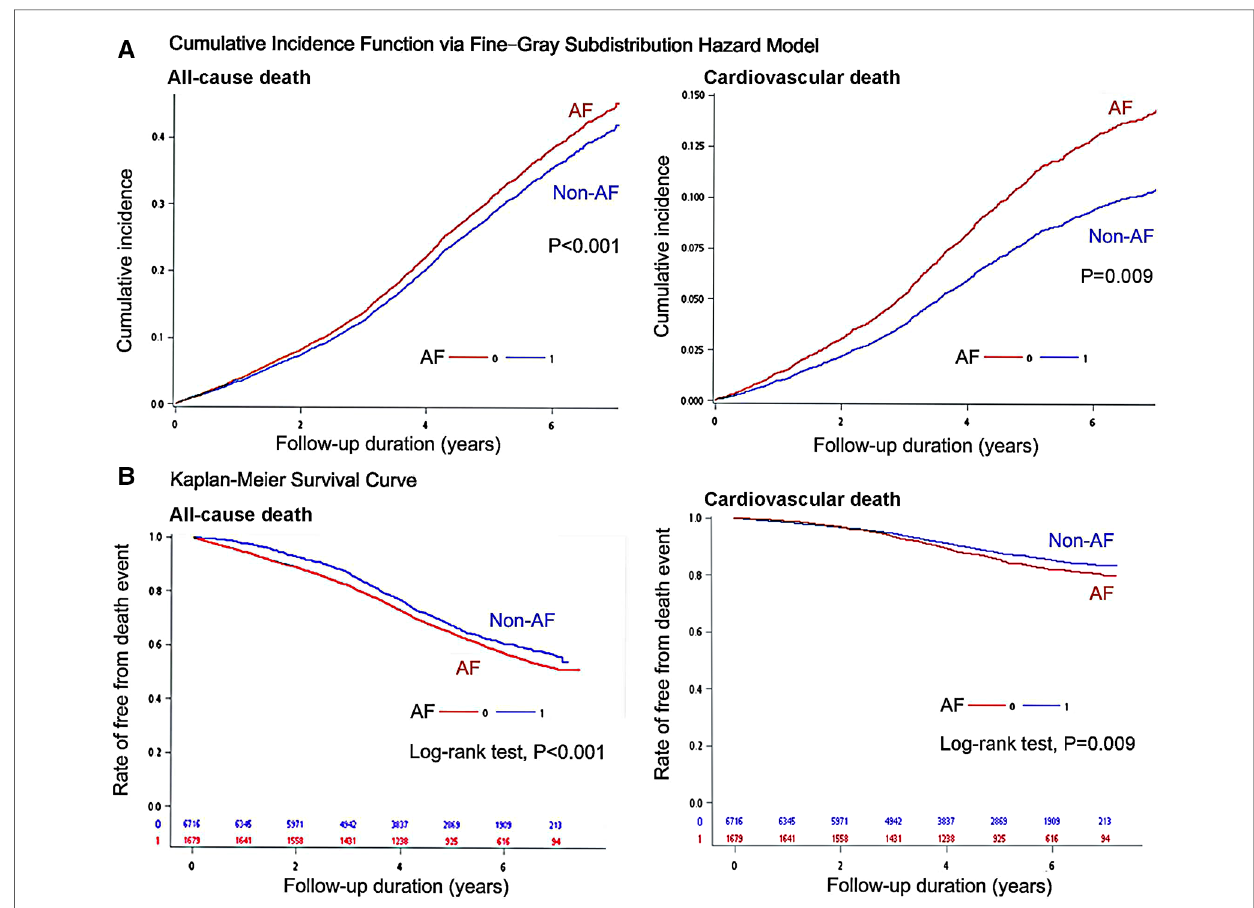
FIGURE 2 Survival analyses of all-cause death and cardiovascular death for evaluating the difference between non-atrial fi brillation (AF) controls and AF patients: ( A ) cumulative incidence function via fi ne-gray subdistribution hazard model, and ( B ) Kaplan – Meier event-free survival curves with log-rank